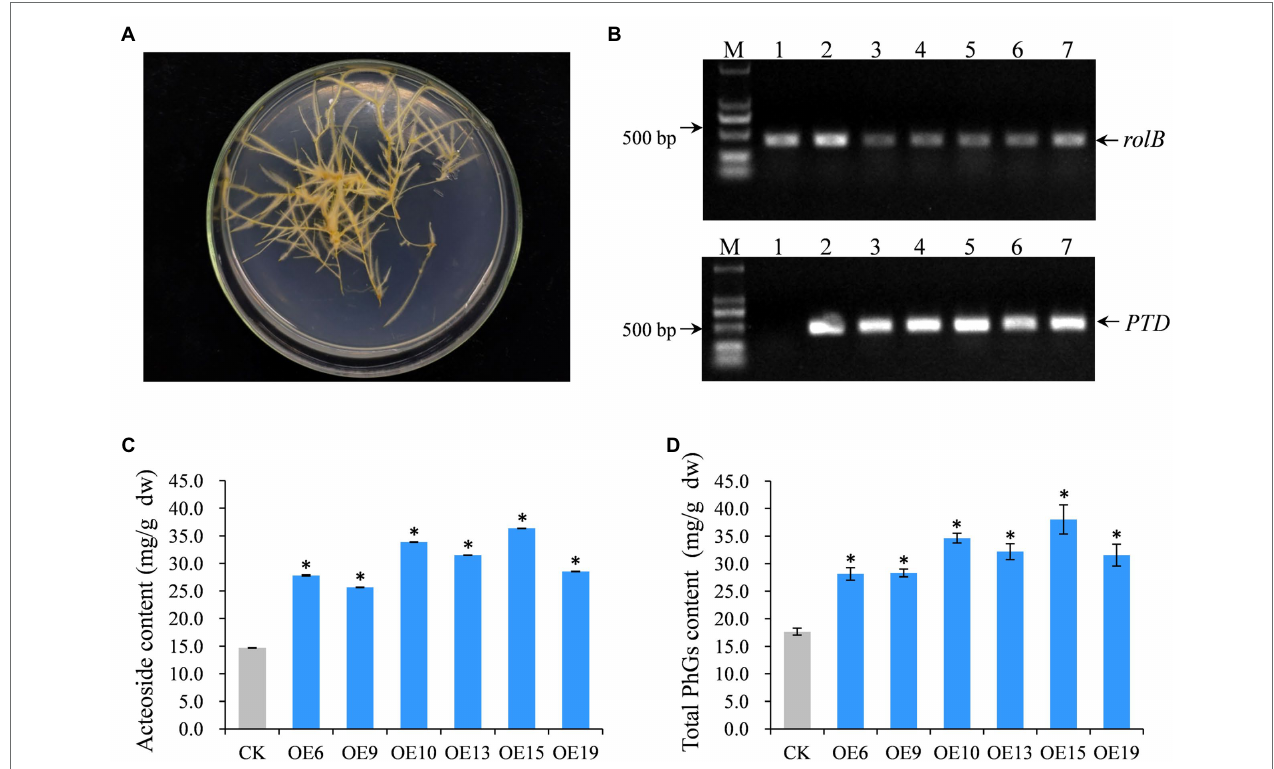
FIGURE 8 | Functional investigation of the RgWRKY37 in hairy root of R. glutinosa . (A) Phenotype of RgWRKY37 overexpressed hairy roots. (B) PCR detection of transgenic R. glutinosa hairy roots using primers of rolB and pBI121. Lane 1, wild-type hairy roots; Lanes 2–7, 35S - RgWRKY37 hairy root lines; and M, DNA Marker. (C) Acteoside content in 35S - RgWRKY37 hairy roots. (D) Total phenylethanoid glycosides (PhGs) in 35S - RgWRKY37 hairy roots. The vertical bars show the SD values ( n = 3). The asterisks indicate statistically significant differences at p <